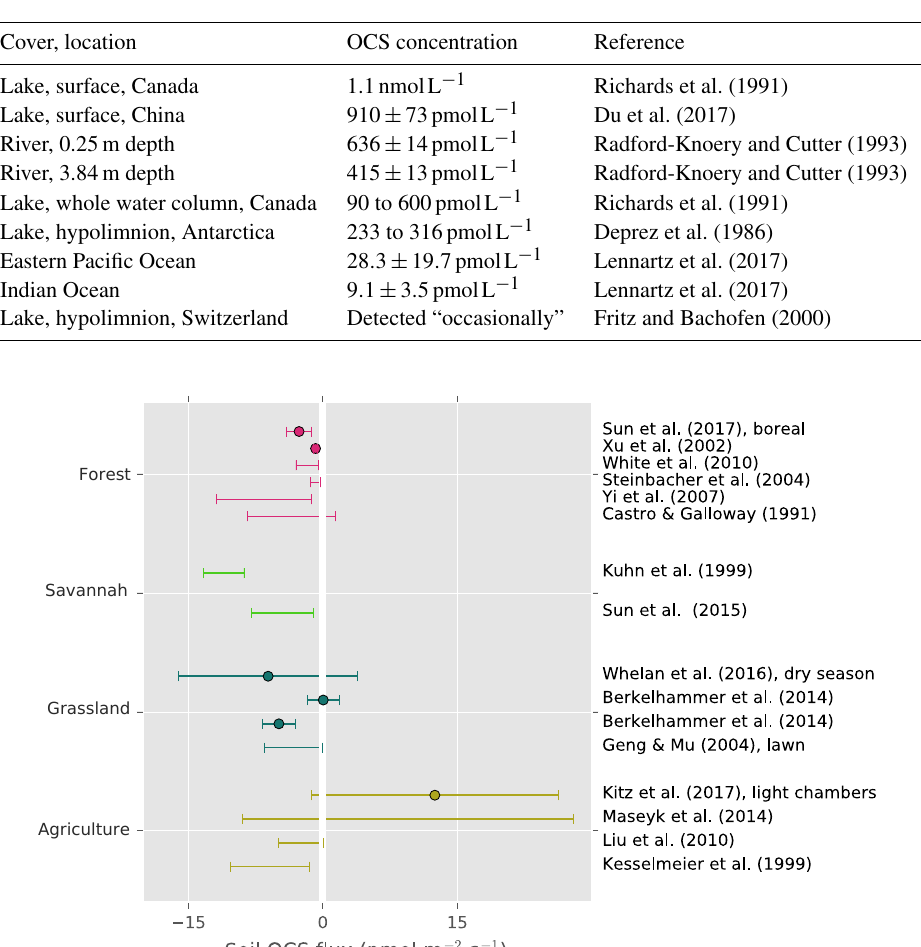
Figure 7. Field observations of soil OCS fluxes. Points are reported averages. Error bars are the reported range or the uncertainty of the average. Kuhn et al. (1999) represents an upper range due to under-pressurized soil